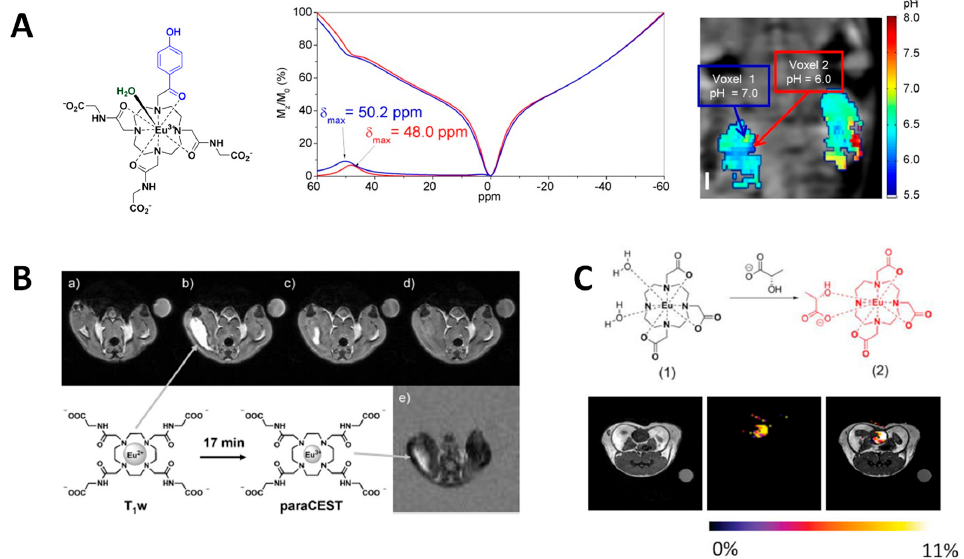
Figure 12. ( A ) The structure of the pH responsive agent (left), fitted CEST spectra (right) with MTRasym profiles for two different single voxels from the left kidney, as indicated in the CEST pH map (right). ( B ) T 1w and CEST imaging of an intramuscular injection of Eu-DOTA-gly4 complex into the thigh muscle of a healthy male C57BL/6J mouse at B0 = 9.4 T. T 1w images at (a) pre-injection, (b) 5 min, (c) 12 min, (d) 16 min, and (e) the CEST image at 17 min. ( C ) The structure of EuDO3A (top), axial view of T1-weighted proton MRI, the CEST image, and the overlay image of a mouse after iv injection of 0.105 mmol/kg EuDO3A and lactate (bottom). The CEST image of the bladder shows that the intact lactate · EuDO3A complex is present at 45 min after iv injection ( n = 3). The CEST image represents amplitude differences between images collected after a 14 μ T presaturation pulse of 5 s duration at ±43 ppm. Adapted with permission from [98,100,101].